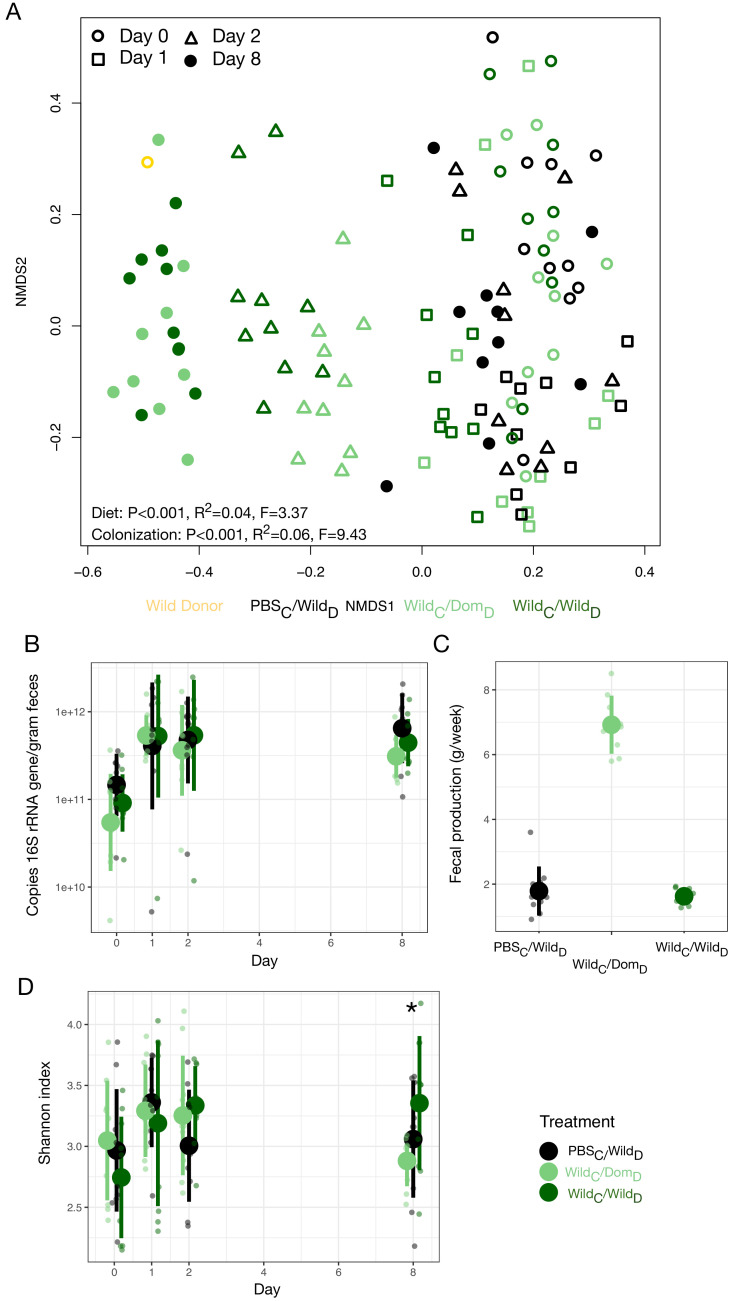
Select microbial and host metabolic parameters under wild colonization treatment.(A) Nonmetric multidimensional scaling (NMDS) ordination of all time points illustrates significant effects (permutational MANOVA tests) of colonization and diet treatment on Bray–Curtis dissimilarity.(B) Microbial load by experimental groups over time. (C) Total fecal production over 1 week differs between experimental groups. (D) Shannon index by experimental groups over time. * indicates p<0.05, Kruskal–Wallis test. Large circles are means; bars show standard deviations.